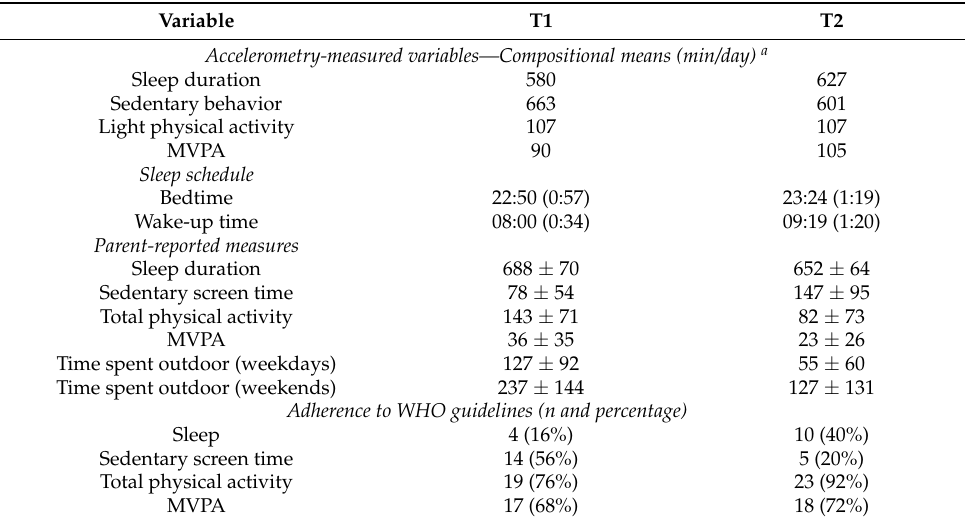
Table 1. Descriptive statistics of measured variables at pre- (T1) and during COVID-19 (T2). Variable T1